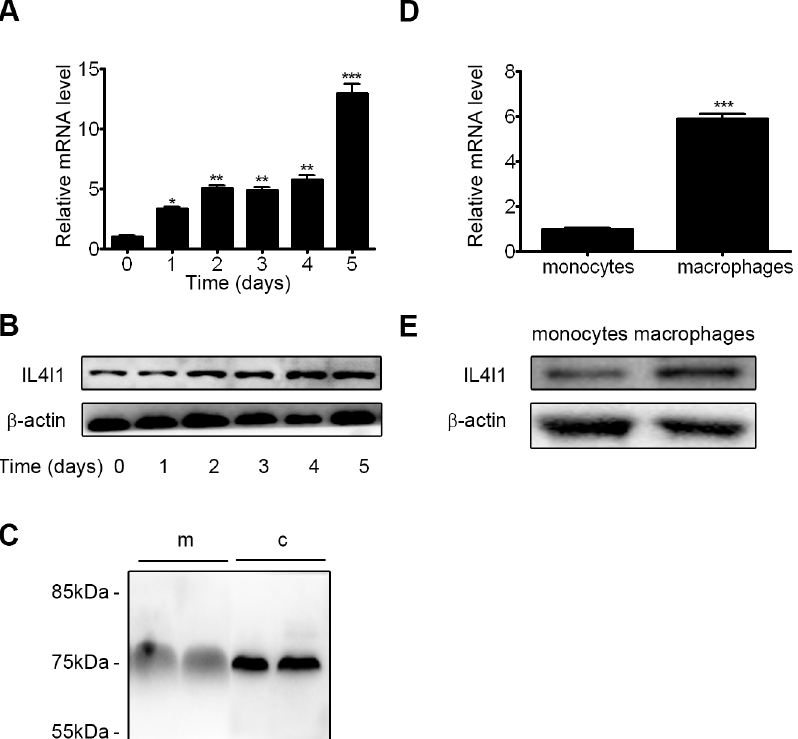
Fig 1. Expression of IL4I1 throughout macrophage differentiation. BM cells at day 0 or during macrophage differentiation in the presence of M-CSF (20 ng/mL) for the indicated periods of time were collected. Levels of IL4I1 gene and IL4I1 protein expression were assessed by q-PCR (A) and western blotting (B), respectively. IL4I1 expression in medium (m) and total cellular proteins (c) from BMDMs were assessed by western blotting (C). Levels of IL4I1 gene and IL4I1 protein expression in primary monocytes and macrophages were assessed by q-PCR (D) and western blotting (E), respectively. All representative data are presented as means ± S.D. for three independent experiments. Significance was calculated by two tailed unpaired Student's t -test. Asterisks indicate significant differences compared to BM cells at day 0; * p < 0.05, ** p < 0.01, *** p <